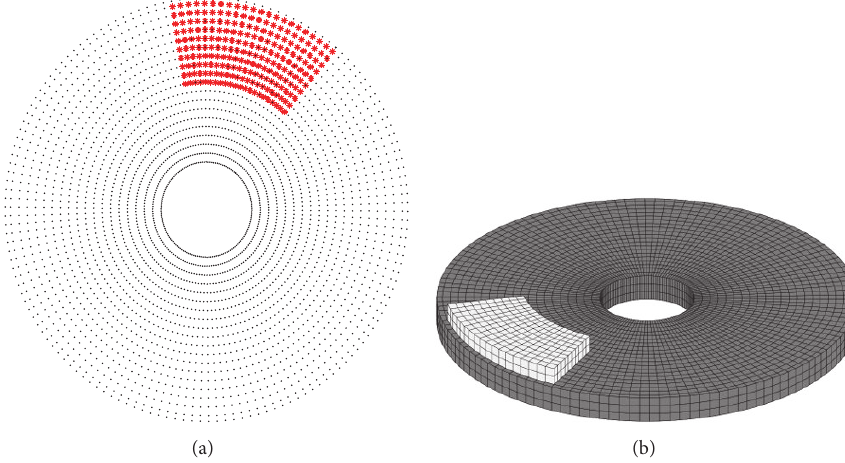
Figure 1: Pad/disc brake system. (a) Viewing of the 220 contact points (red). (b) Finite element model.